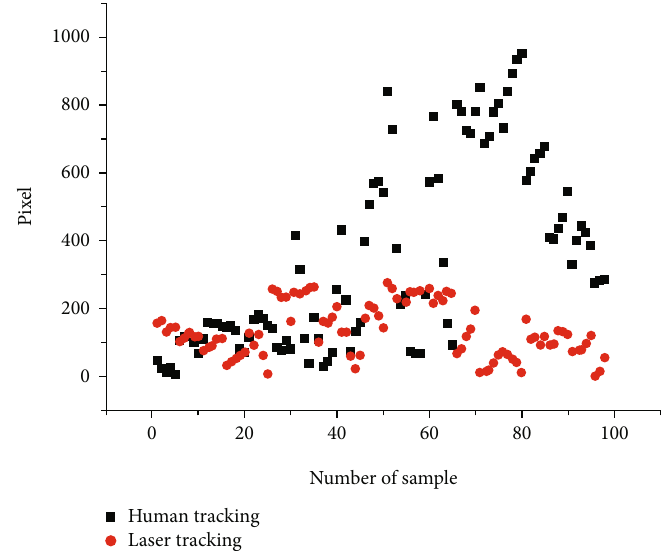
Figure 10: A graph comparing videos taken by camera operator and developed system.